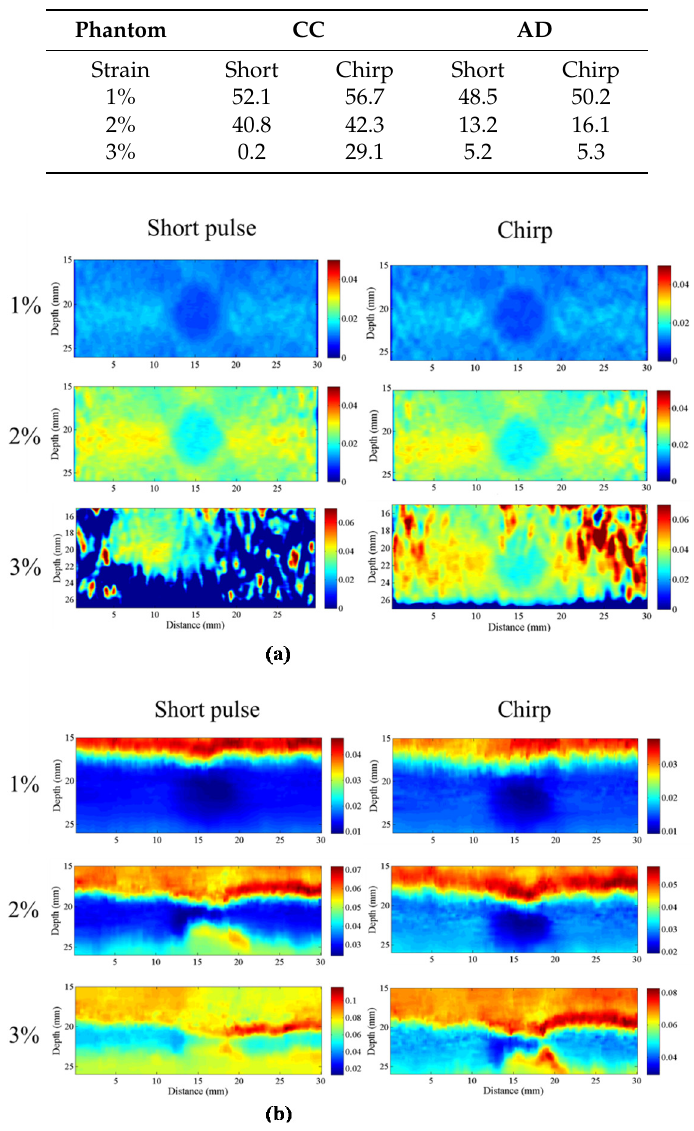
Figure 24. Strain images of a lesion phantom with 1%, 2% and 3% strain applied from top. ( a ) CC algorithm; and ( b ) AD